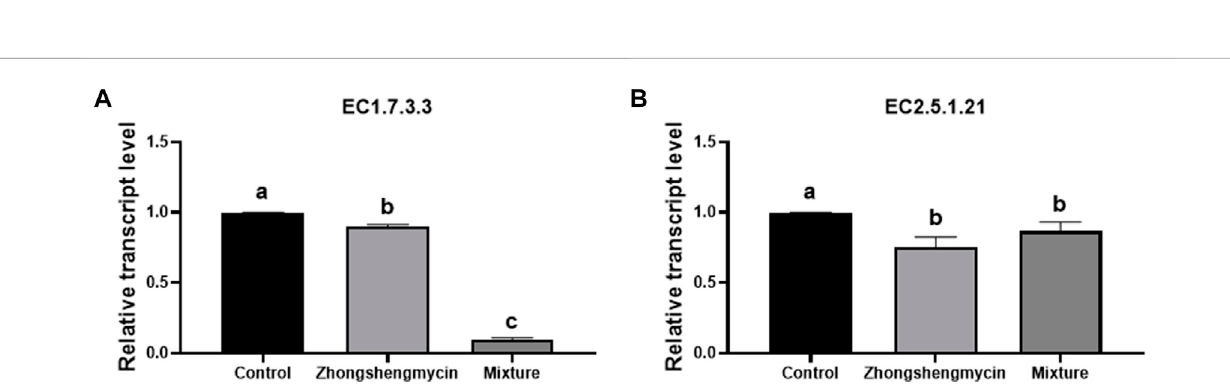
FIGURE 3 Expression level of EC1.7.3.3 and EC2.5.1.2.1 in N. lugens (A) Expression of EC1.7.3.3 in N. lugens with different treatments, (B) expression of EC2.5.1.2.1 in N. lugens with differenttreatments.After 72 h, 15surviving individuals fromeach treatment group wereisolated for RNAextractionand RT- qPCR analysis. Data are presented as the means ± standard error. Statistical analyses were conducted using one-way ANOVA and unpaired two-tailed Student ’ s t-test using GraphPad Prism Software 8.0.2 (GraphPad Software, San Diego, CA, United States). Lowercase letters indicate signi fi cant differences ( p <